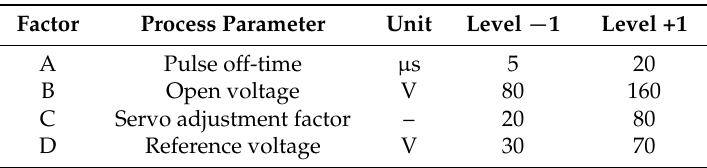
Table 1. Design of Experiments (DoE): factors and levels.